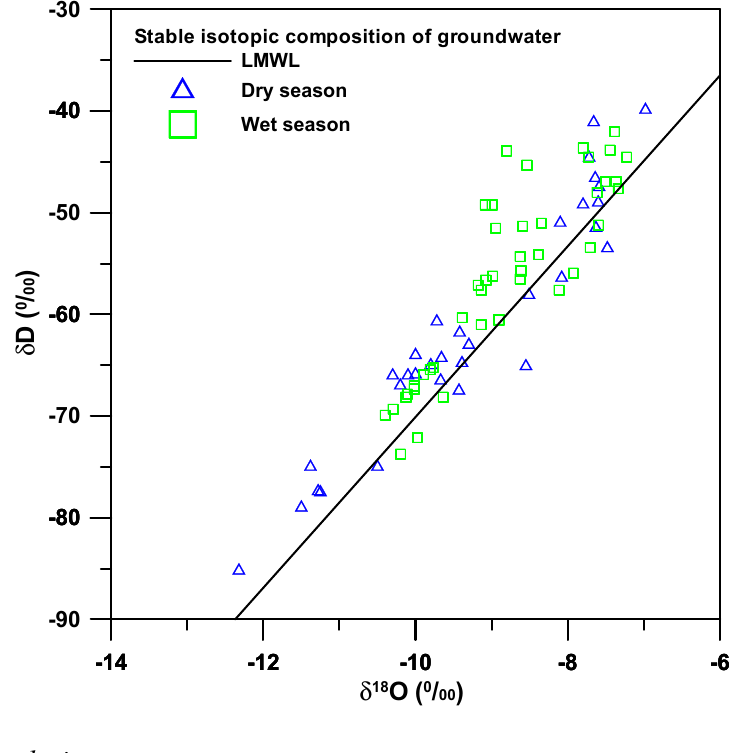
Figure 5. Plot of δ D vs. δ 18 O of groundwater